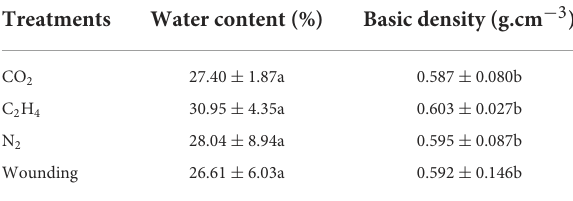
* Data are shown as means ± standard deviation. Values with the same letters are not significantly different from each other according to Duncan’s multiple comparison ( α =